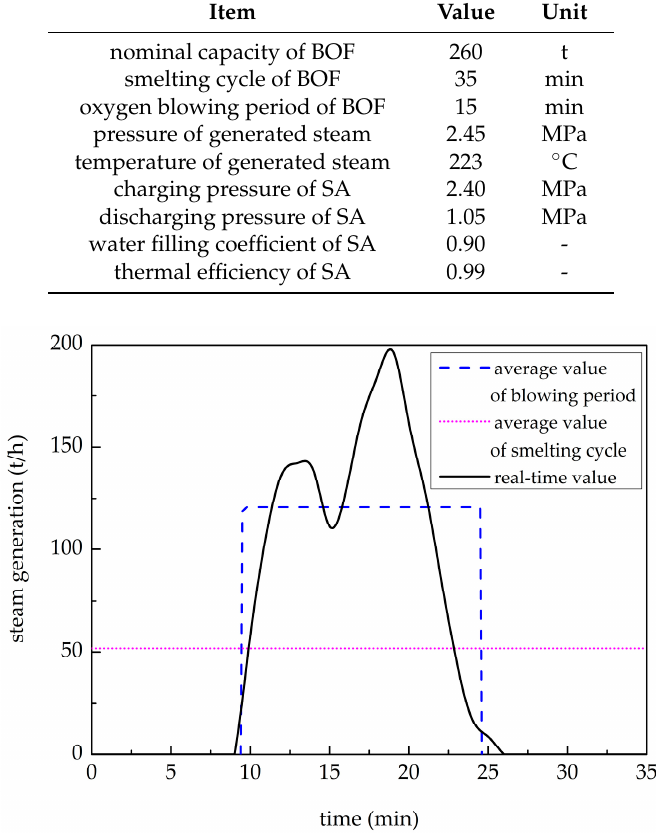
Figure 8. Steam generation of a 260 t BOF. The solid line denotes the real-time load value; the dashed line denotes the average value of the blowing period; and the short dot denotes the average value of smelting cycle.